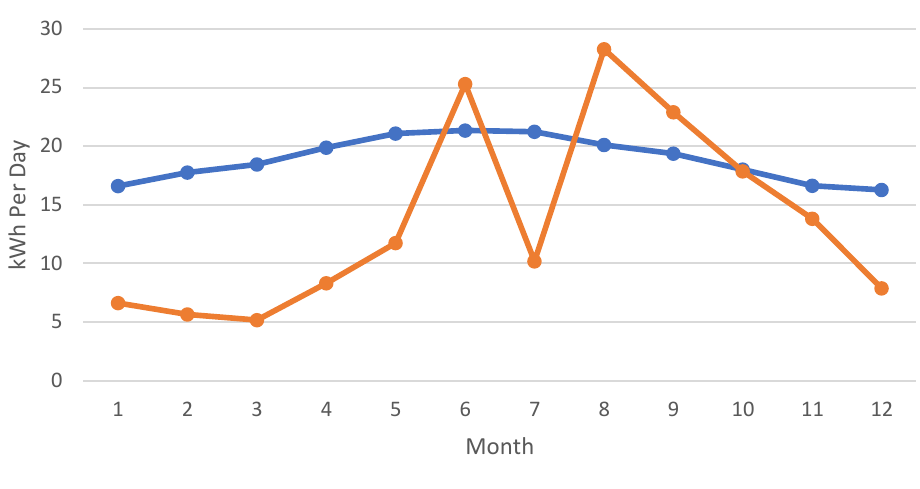
Panels Total Generated Power Figure 10. HPE vs. LPN (50% vs. 2 Figure 10. HPE vs. LPN (50% vs. 2 panels) .